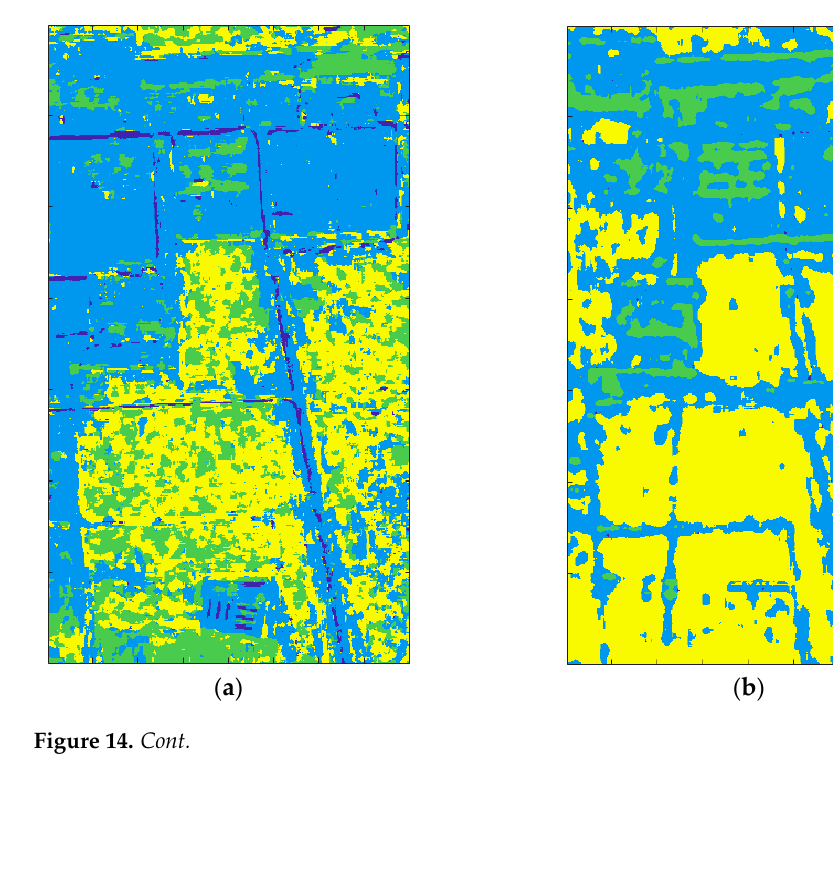
Figure 13. Groud truth map of Baotou City Dataset.